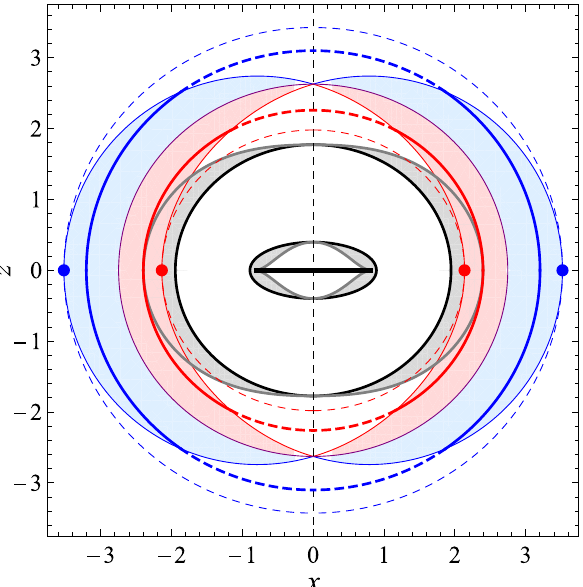
Fig. 11 Illustration of some characteristics of the KdS spacetime with parameters a 2 = 0 . 64 , y = 0 . 02 . The labels x , z are the Kerr–Schild coordinates, the y -coordinate is suppressed. The horizontal abscissa is the ring singularity, black ellipses mark the black-hole event horizons, graycurvesrepresentthestaticlimitsurface(ergosurface),blackdashed vertical line is the rotary axis. The ergosphere is denoted by shading; note, however, that the shading is canceled by colors corresponding to various types of the spherical photon orbits located at the ergosphere (here and in the following figures representing the classification). The outer ergosphere and the cosmological horizon is outside of the draw- ing in this figure. Thin dashed red ellipse denotes the sphere with radius r = r ph + = 1 . 98 , which intersects the equatorial plane in the co- rotating photon circular orbit, displayed as red bold points. Similarly, thin dashed blue ellipse represents the r = r ph2 = 3 . 43 sphere, and the bold blue points mark the equatorial counter-rotating circular orbit. Bold red arcs represent a prograde spherical photon orbit at r = 2 . 26 , selected just to touch the ergosurface in the equatorial plane. Thick red dashedarcsdenotetherestoftheselectedsphere.Accordingly,fullparts of the bold blue ellipse mark some spherical retrograde photon orbit, selected at r = 3 . 1 . The endpoints of the bold arcs then correspond to marginal latitudes, among which the photons oscillate. All such end- points thus createa surface, here depictedby full thinred or blue curves, limitingregionsfilledbytheprogradeorretrograde,respectively,spher- ical photon orbits, colored in light red or blue, respectively. In this case, the regions of opposite orientations are separated by purple ellipse rep- resenting the polar spherical orbit at which a photon with X = − a ( (cid:11) = 0) crosses the spacetime rotation axis alternately above the two poles. We reserved light/full hues to regions of unstable/stable orbits, the latter ones not being present in this case. In some KdS spacetimes, there exist retrograde spherical orbits of photons with X > − a . They are confined exclusively inside the ergosphere and occupied by photons with negative energy E . These regions will be depicted in